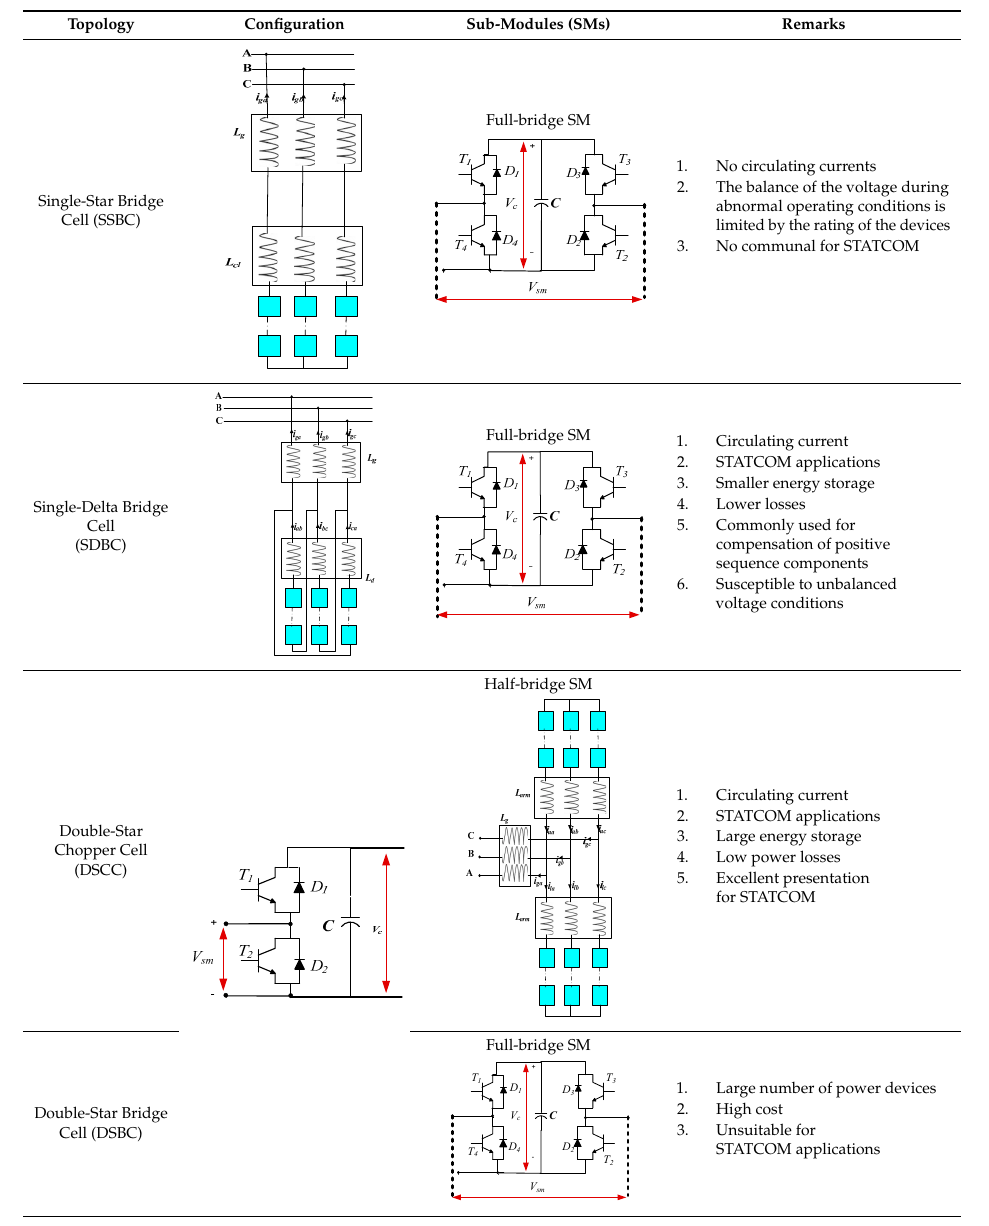
Table 1. Comprehensive comparison between Modular Multilevel Converter (MMC)